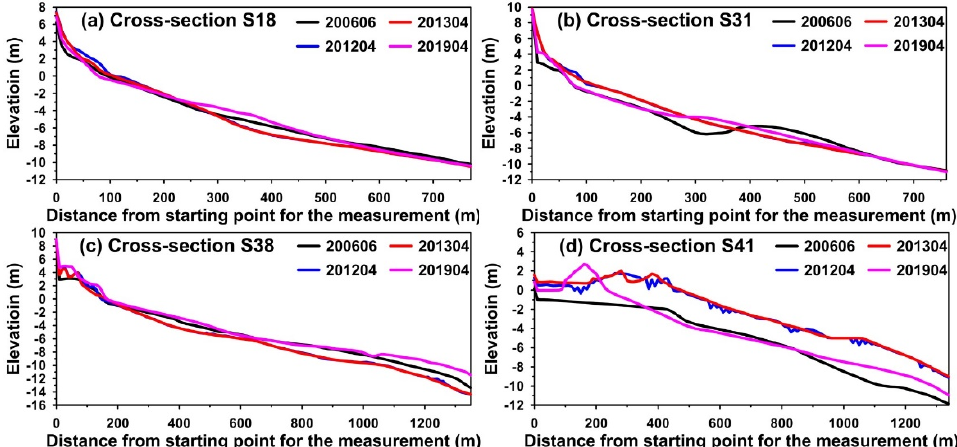
Figure 11. Cross-shore bathymetry profile comparisons for ( a ) S18, ( b ) S31, ( c ) S38, and ( d ) S41 cross sections measured in various years.